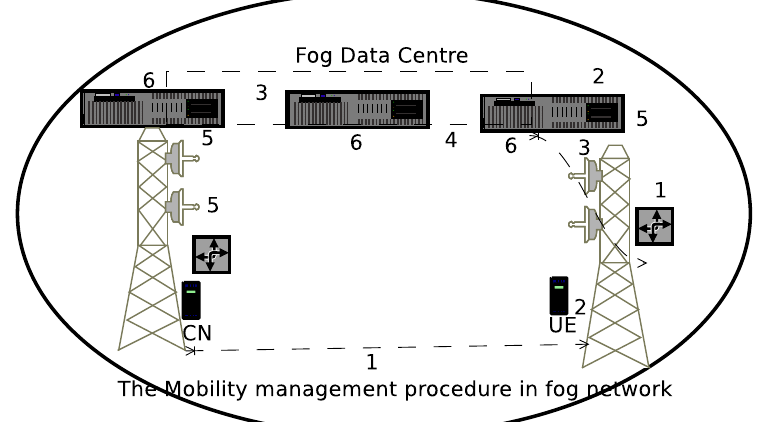
Figure 5. The mobility management technique in device-driven 5G fog